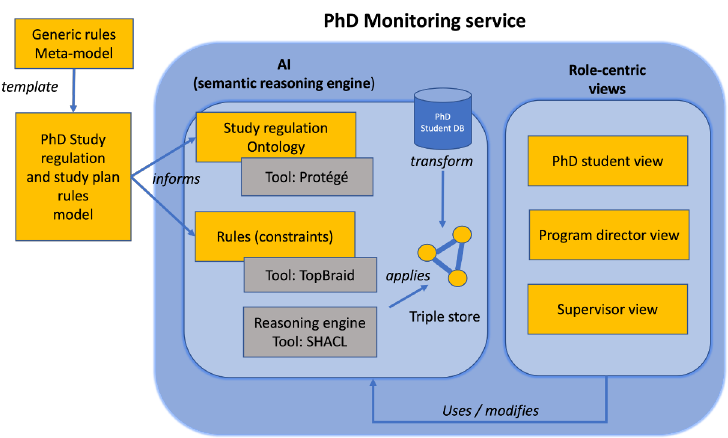
Figure 6: General overview of the PhD monitoring service - including compliance to regula- tions and study